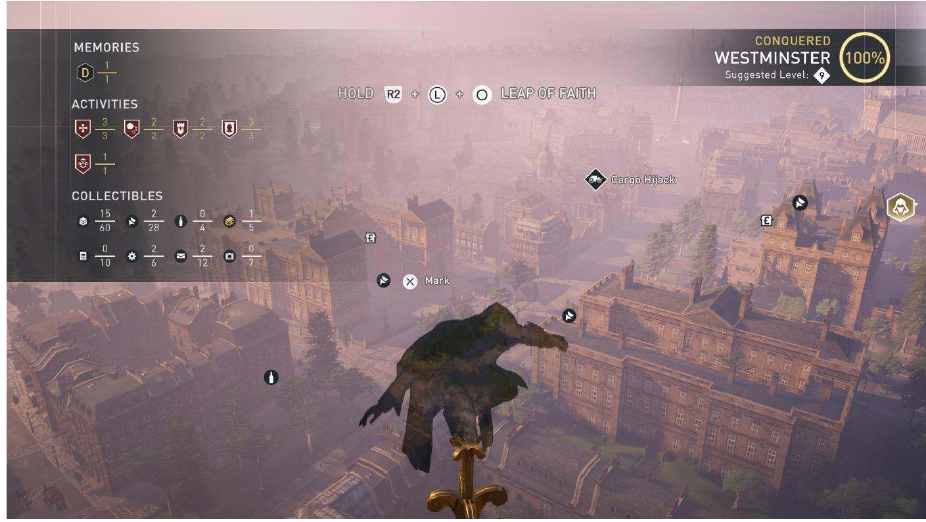
Credits: Assassin’s Creed Syndicate , Ubisoft.